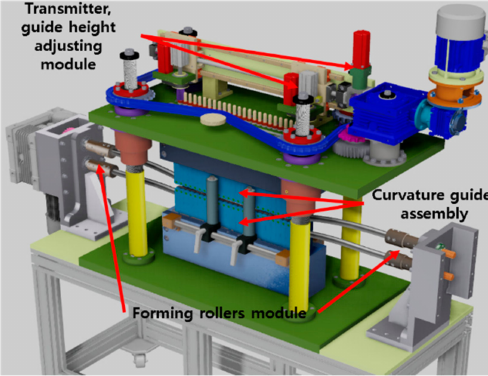
Figure 2. Configuration of the entire equipment.